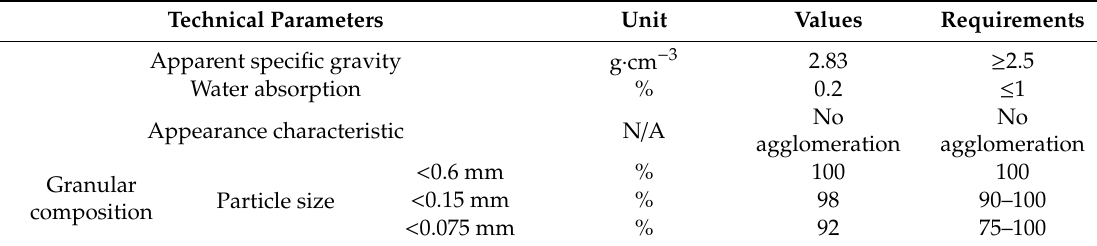
Table 4. Technical parameters of mineral